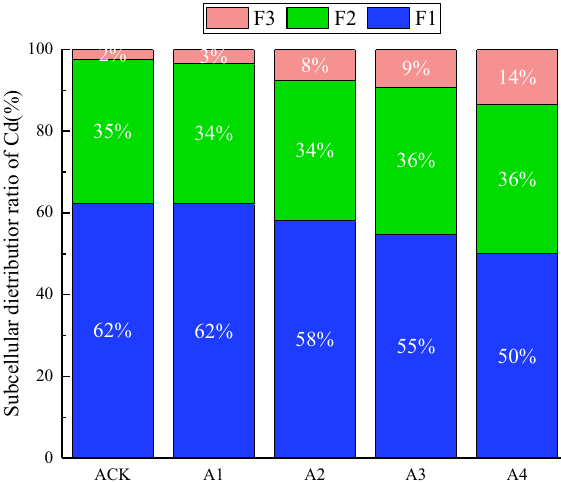
Figure 1. Subcellular distribution of Cd in maidenhair.